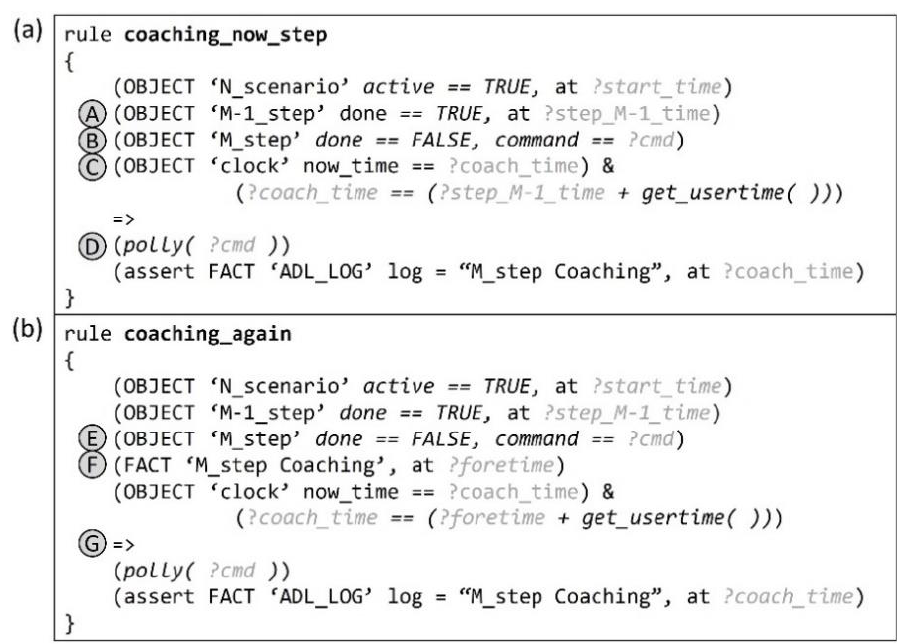
Figure 13. ( a ) Rule for coaching when a user does not do anything even after the time limit for the step has elapsed. ( b ) Rule for determining the situation when the same coaching should be done over the time